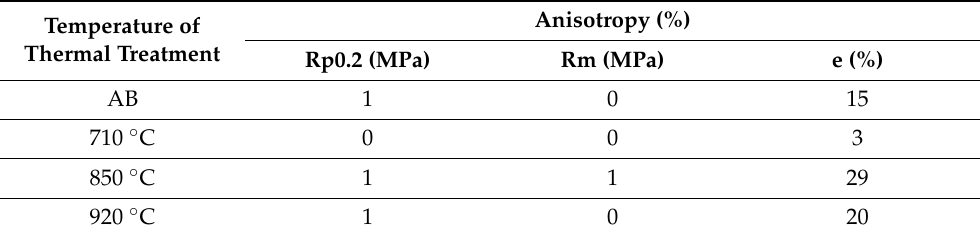
Table 6. Anisotropy of tensile properties calculated for three overlapped weld bead strategy after each thermal treatment.